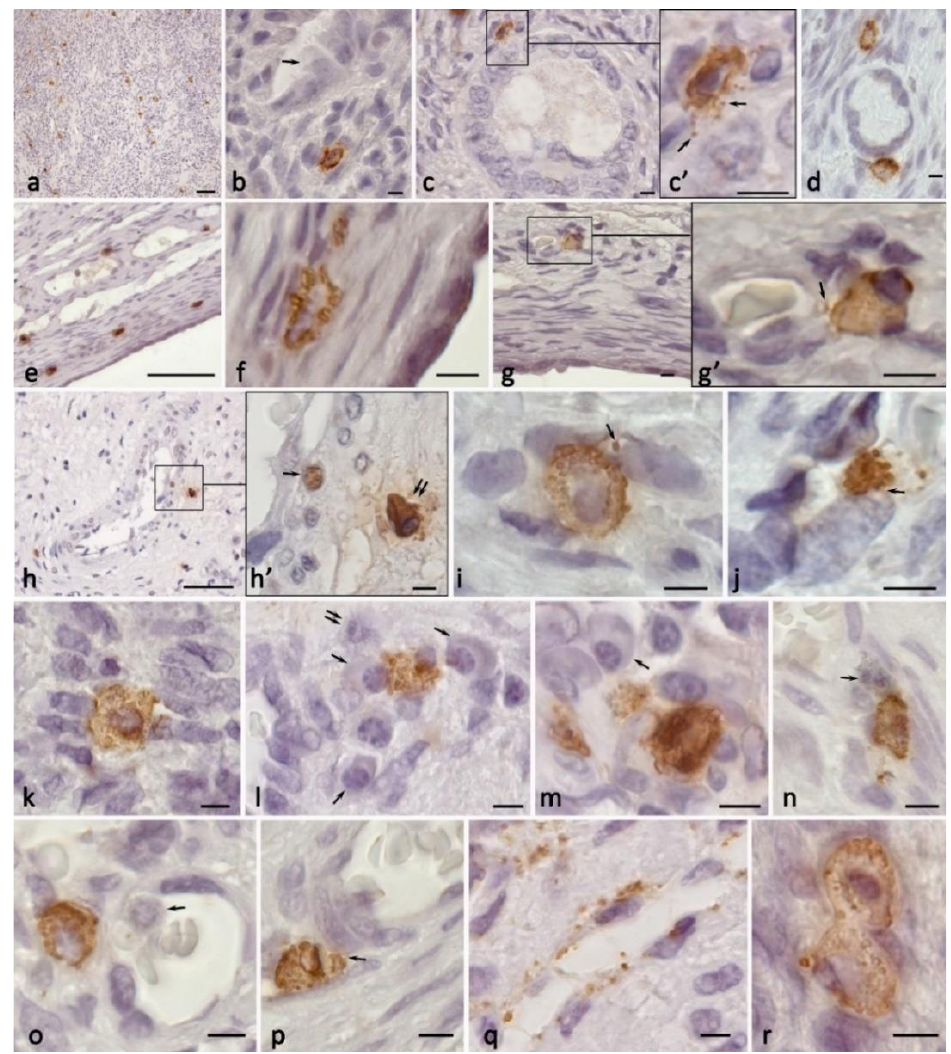
Figure 2. Tryptase-positive MCs in the specific tissue microenvironment of the ovary under the formation of endometrioid cysts. ( a ) An increased MC population in the ovarian medulla. ( b ) Localization of MCs in the tissue microenvironment of the endometrioid cyst (indicated by the arrow). ( c ) Target tryptase secretion to the basement membrane of the follicular epithelium of the secondary follicle (indicated by an arrow). ( d ) MCs in the tissue microenvironment of the primary follicle. ( e – g ) Increased number of MCs in the albuginea with active tryptase secretion, including that to the basement membrane of the endothelium (( g ), indicated by an arrow). ( h ) Perivascular localization of MCs with active tryptase secretion (indicated by a double arrow) with penetration into the nuclei of stromal cells (indicated by an arrow). ( c (cid:48) ), ( g (cid:48) ) and ( h (cid:48) ) are enlarged fragments of ( c ), ( g ) and ( h ), respectively. ( i , j ) Target secretion of tryptase to ovarian stroma fibroblasts (indicated by an arrow). ( k ) Simultaneous contacting of MCs with several cells of the cytogenic stroma. ( l – n ) Interaction of MC with immunocompetent cells, including plasma cells (indicated by an arrow) and granulocyte (indicated by a double arrow) ( l , m ), eosinophil (indicated by an arrow) ( n ). ( o ) Tryptase-induced transendothelial migration of a granulocyte (indicated by an arrow) into the cytogenic stroma of the ovarian medulla. ( p ) Selective effect of tryptase on pericyte (indicated by an arrow). ( q ) Localization of tryptase-positive MC granules in the periendothelial layer of the stroma of the ovarian medulla. ( r ) Contacting MCs. Scale: ( a , e , h ) 50 µ m, the rest—5 µ